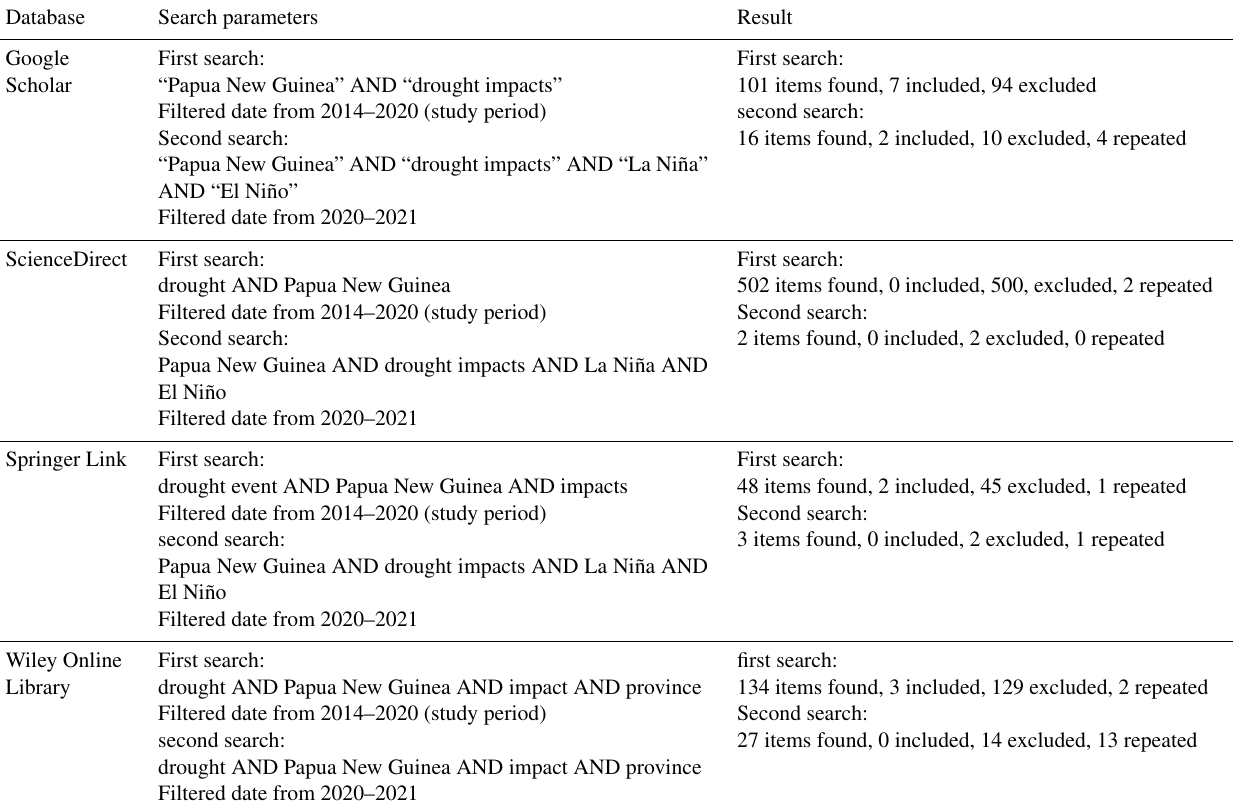
Table 7. Search parameters used to gather literature sources for the risk assessment